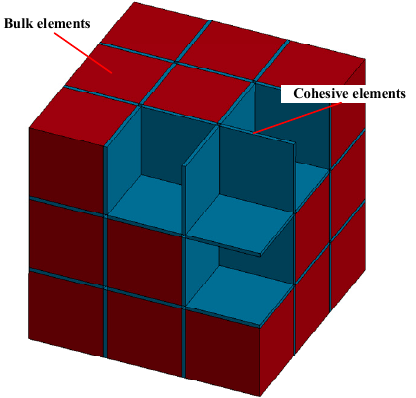
Figure 1. Element types of cohesive element method (CEM).